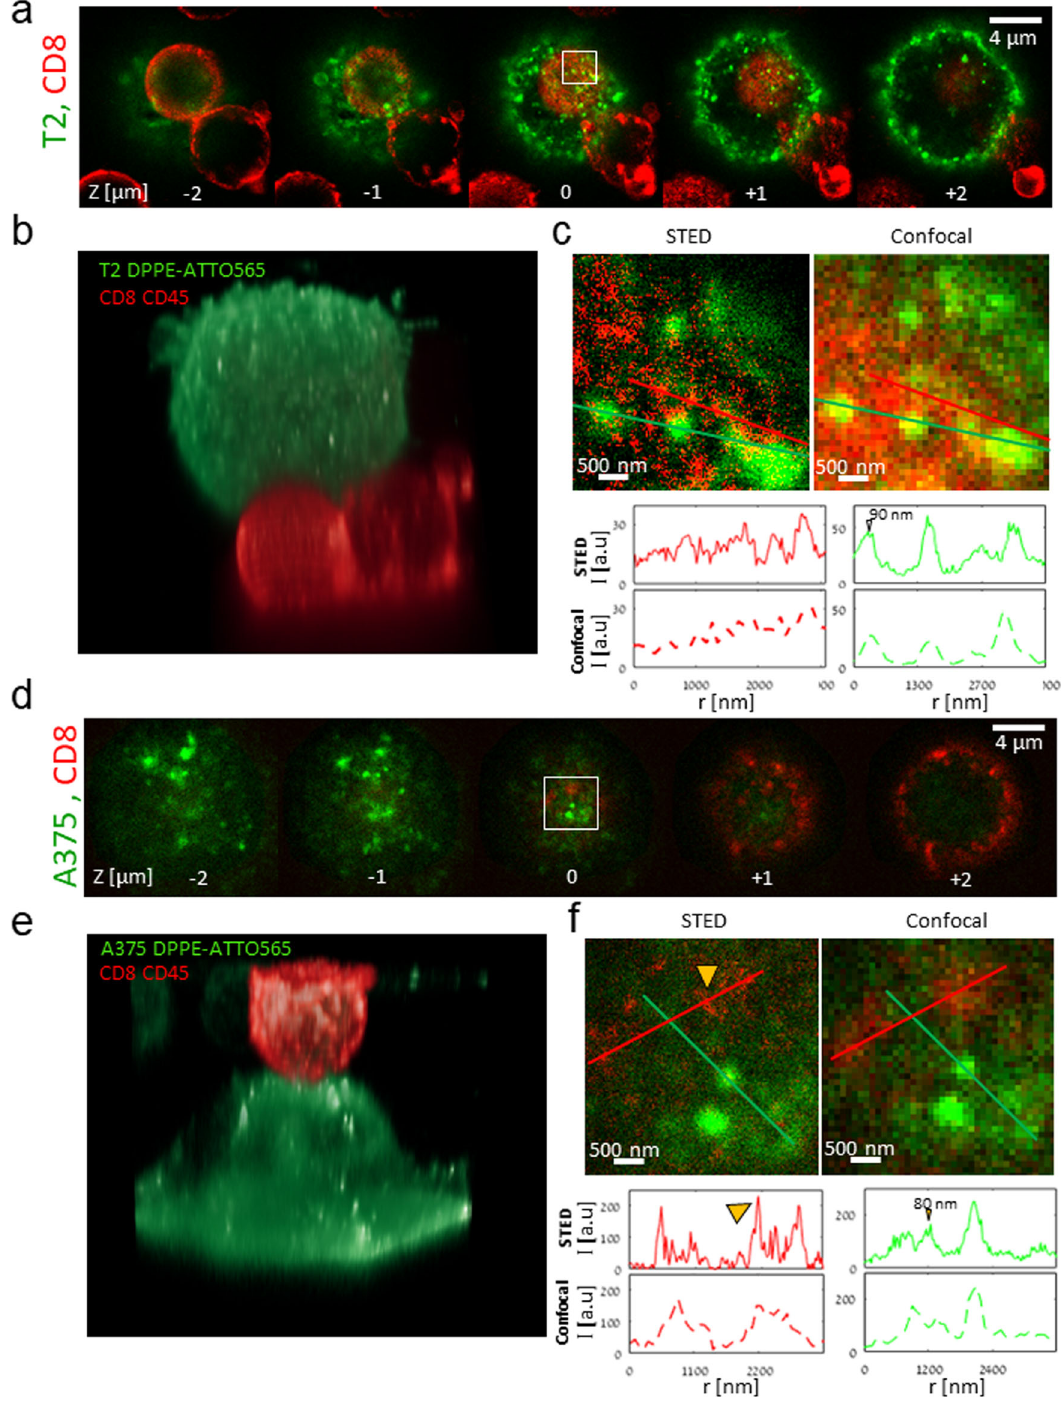
Fig. 2 STED microscopy of CD8 + T cell conjugates with APCs and melanoma cells. a STED images of cell conjugates of CD8 + T cells with T2 cells loaded with the activating peptide NY-ESO-1. The PM of the CD8 + T cells was stained for α CD45 and Alexa647 (red) and the PM of the T2 cells was stained using DPEE-Atto565 (green). Images are shown at different heights (focal planes) relative to the cell interface. b Three-dimensional rendering of the cell conjugates in panel a . c Zoom images of the confocal and STED images are shown for the zoom area in panel a at z = 0 (middle image). Intensity of either green or red channels is shown across line pro fi les (indicated as colored lines, respectively) in the top-row images. The width of small objects (peaks) of interest are indicated. d STED images of cell conjugates of CD8 + T cells with A375 (melanoma) cells. The PM of the CD8 + T cells was stained for α CD45 and Alexa647 (red) and the PM of the A375 cells were stained using DPEE-Atto565 (green). Images are shown at different heights (focal planes) relative to the cell interface. e Three-dimensional rendering of the cell conjugates in panel d . f Zoom images of the confocal and STED images are shown for the zoom area in panel d at z = 0 (middle image). Intensity of either green or red channels is shown across line pro fi les (indicated as colored lines, respectively) in the top-row images. Yellow arrowheads indicate features of interest in the image and on the intensity line pro fi les. The widths of small objects (peaks) of interest are